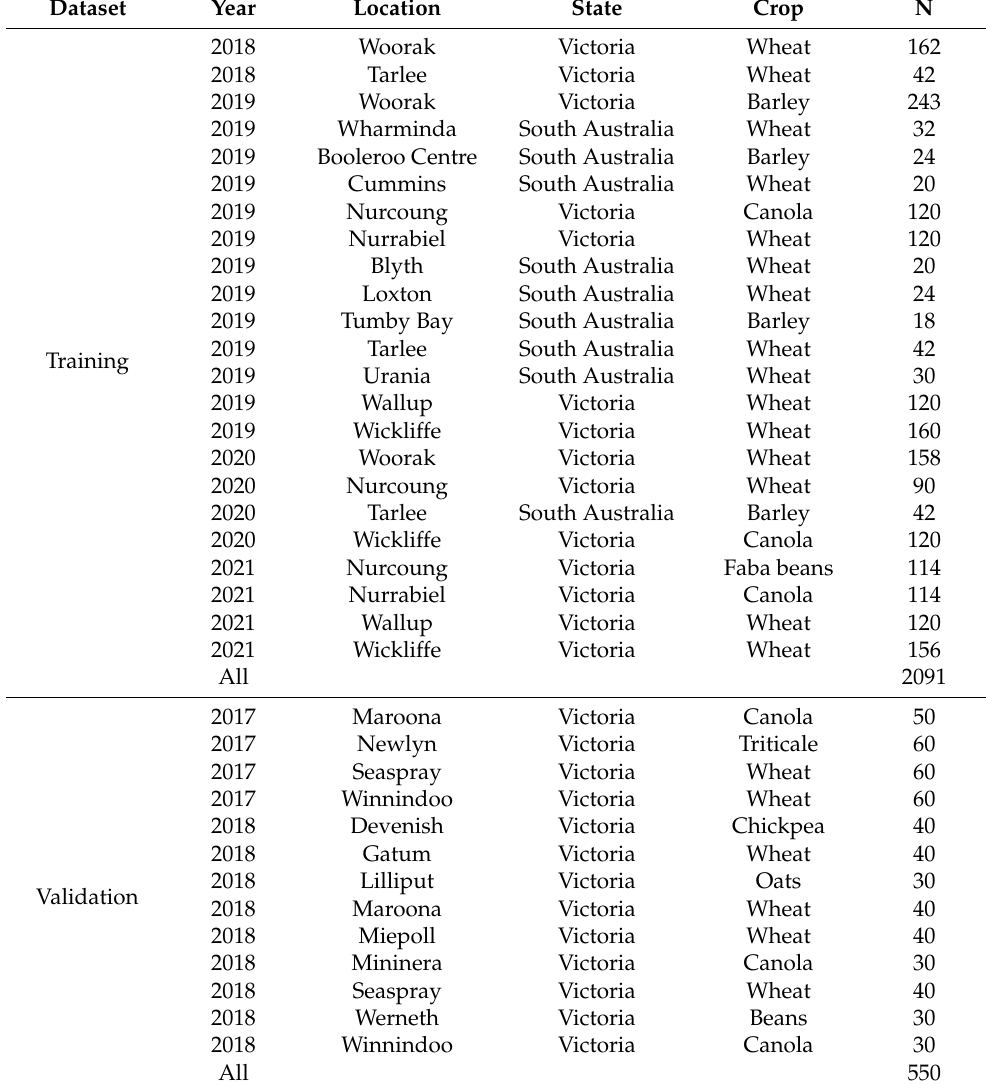
Table 1. Crop biomass